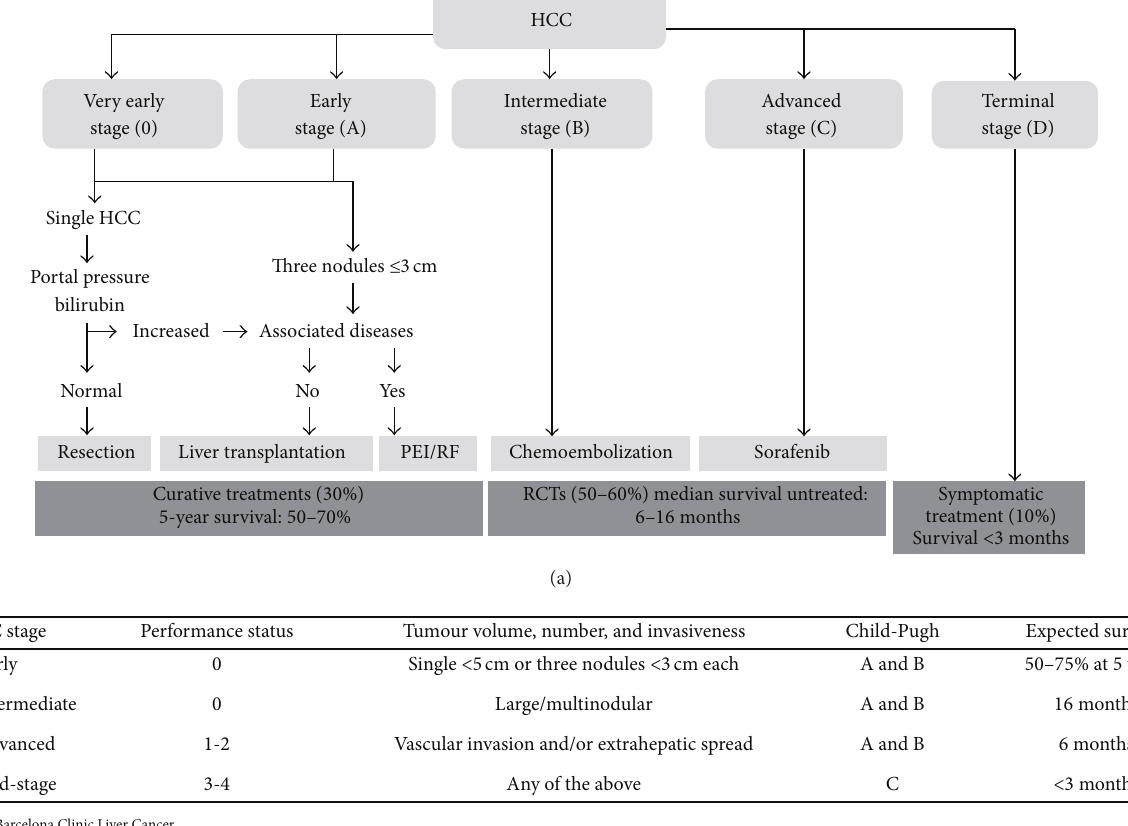
trial of 230 patients within the Milan criteria (BCLC stage